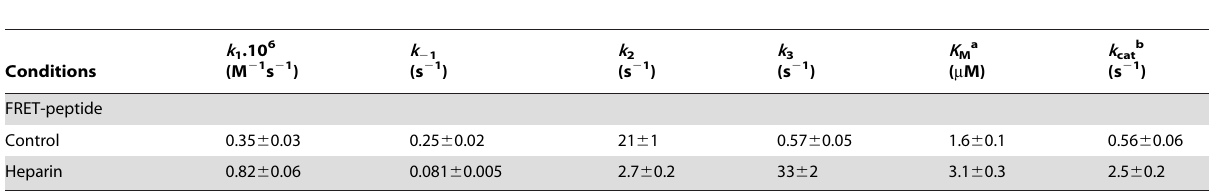
Table 2. Effect of heparin on pre-steady-state kinetic parameters for hydrolysis of FRET-peptide substrate by human neutrophil